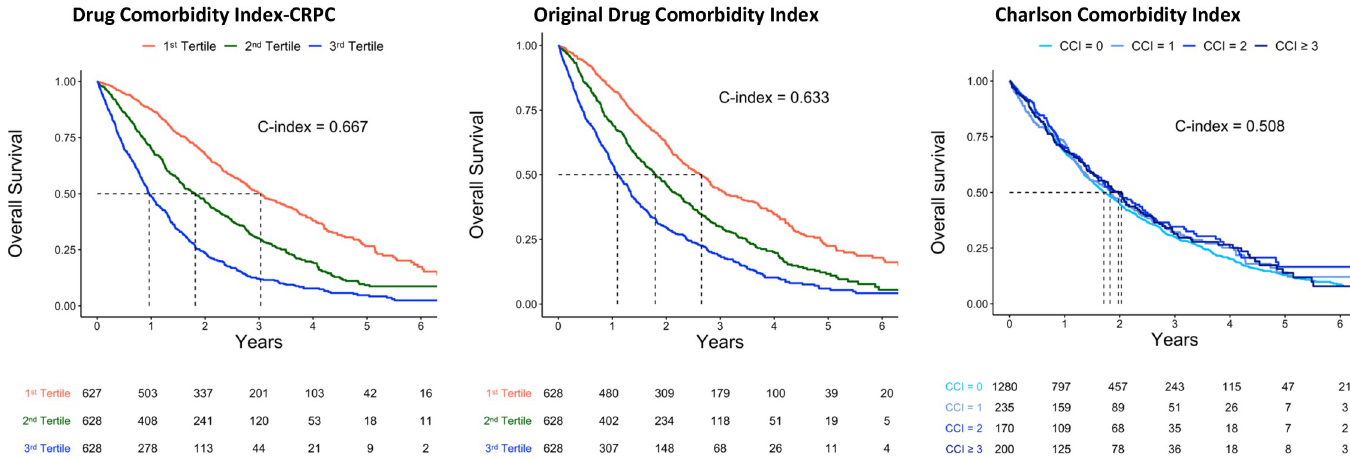
Fig 1. Overall survival for 1885 men with castration resistant prostate cancer (CRPC), stratified in tertiles of the Drug Comorbidity Index developed for CRPC (DCI-CRPC), the original DCI, and the Charlson Comorbidity Index.